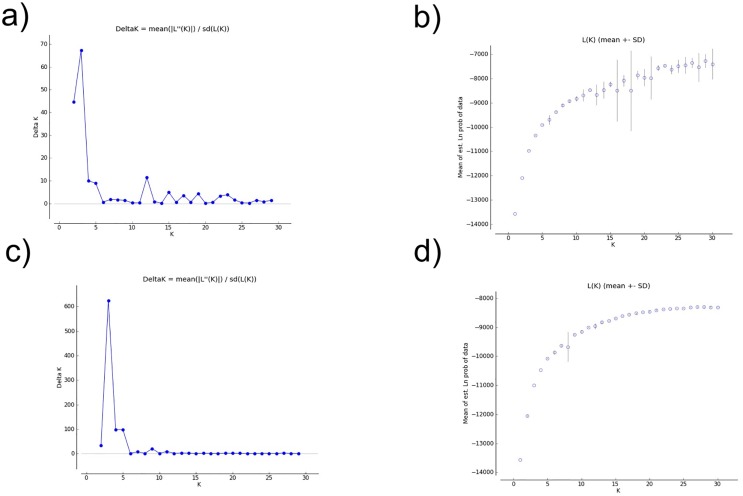
Results of the STRUCTURE analysis (10 runs each for K = 1–30) to infer population structure of studied Pulsatilla patens s.s. populations.a) values of Evanno’s admixture analysis; b) values of Evanno’s non admixture analysis; c) Posterior probabilities lnP(K)-admixture analysis; d) Posterior probabilities lnP(K)-non admixture analysis.